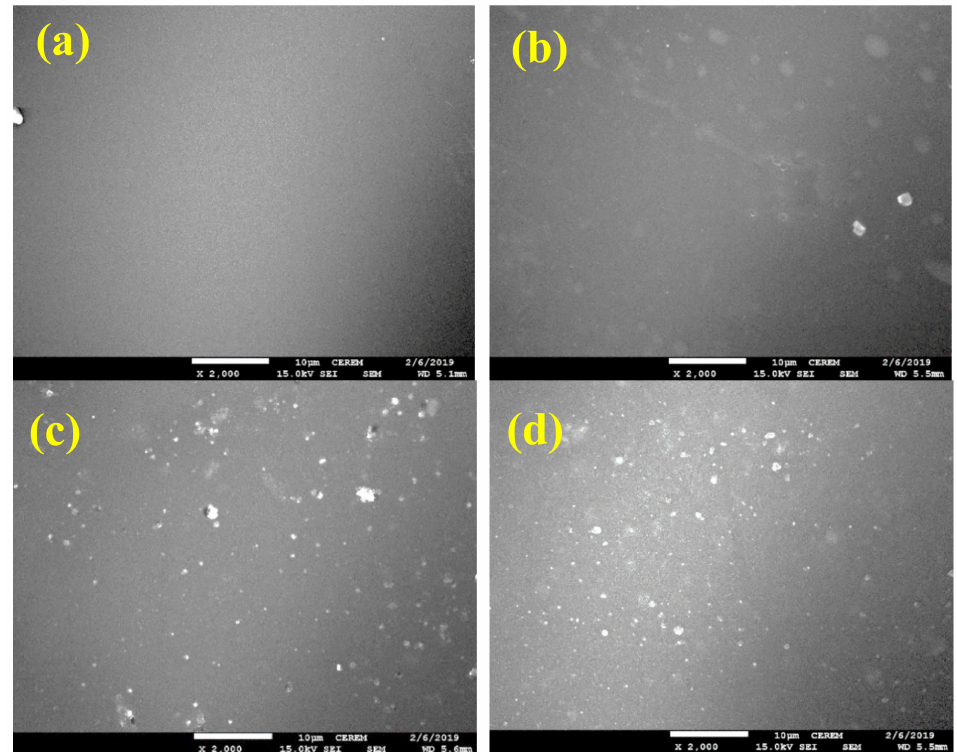
Figure 12. SEM micrographs obtained for the surface of ( a ) the epoxy coating without SiO 2 present, ( b ) SN1, ( c ) SN3, and ( d ) SN5, which were applied on the mild steel coupons before being immersed in the test